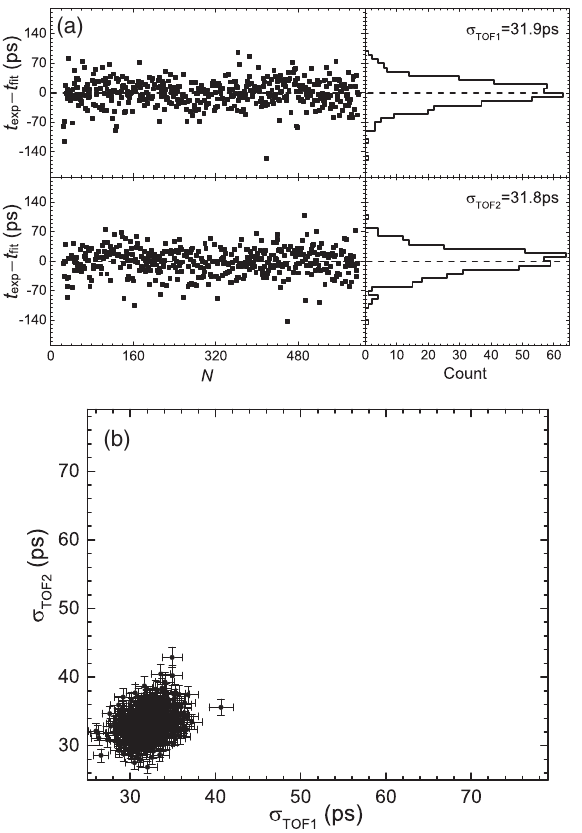
FIG. 8. Same as Fig. 6, but using Eq. (7) in the fitting procedure.